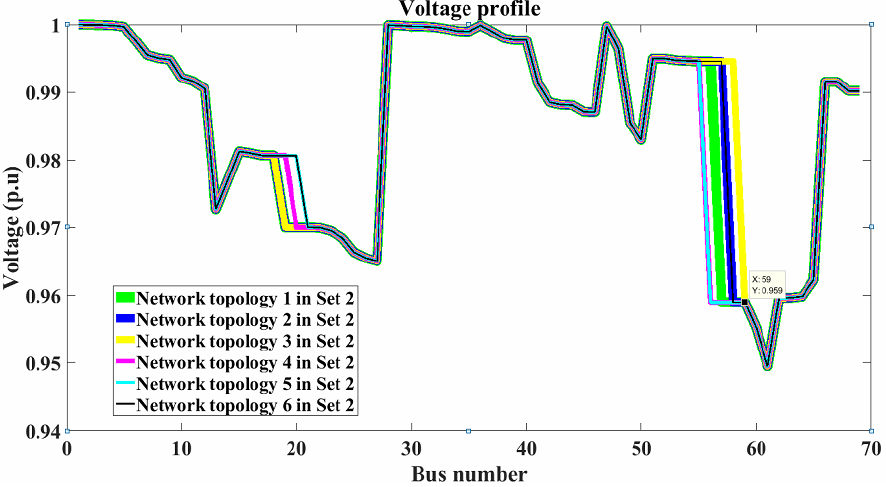
Figure 8. Voltage profiles of optimum network topologies for the 69-bus distribution system in Set 2.